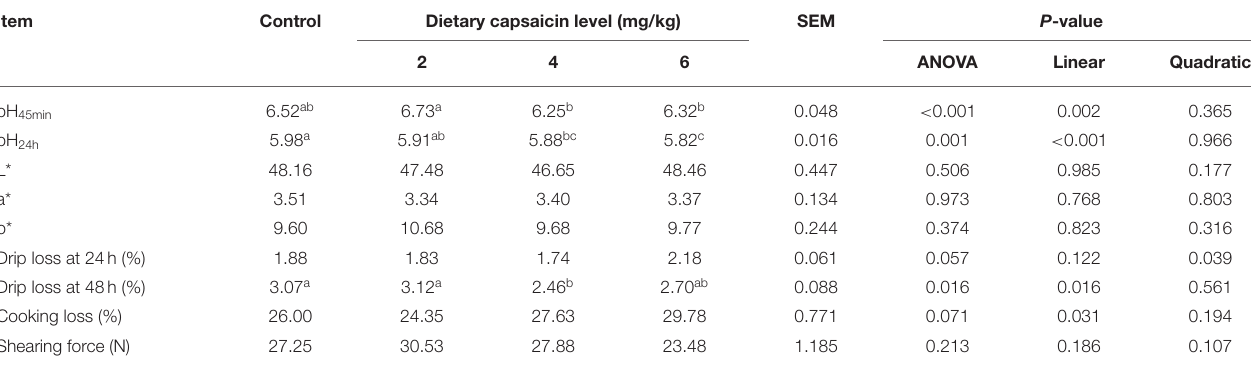
TABLE 4 | Effects of different levels of capsaicin on meat quality of breast muscle in broilers at 42 d. Item Control